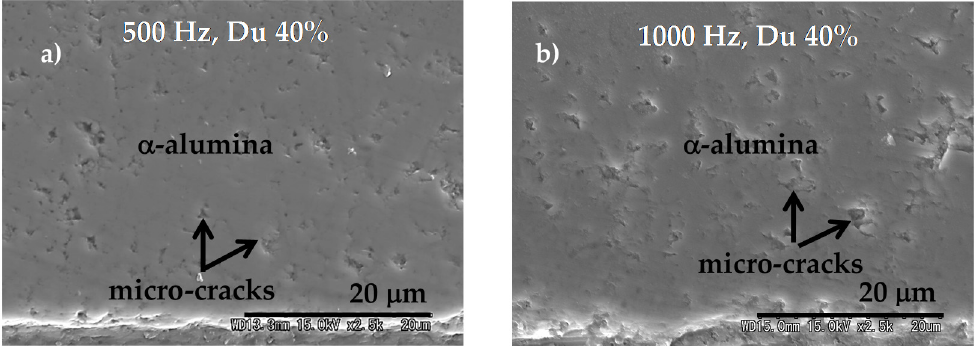
Figure 8. SEM image of cross-section of alumina layer on the Ti alloy formed by MAO of CS-Al layer at pulse frequency of 500 Hz ( a ) and 1000 Hz ( b ) both at duty cycle of 40% for 60 min. Reproduced from [102] with permission from Elsevier.